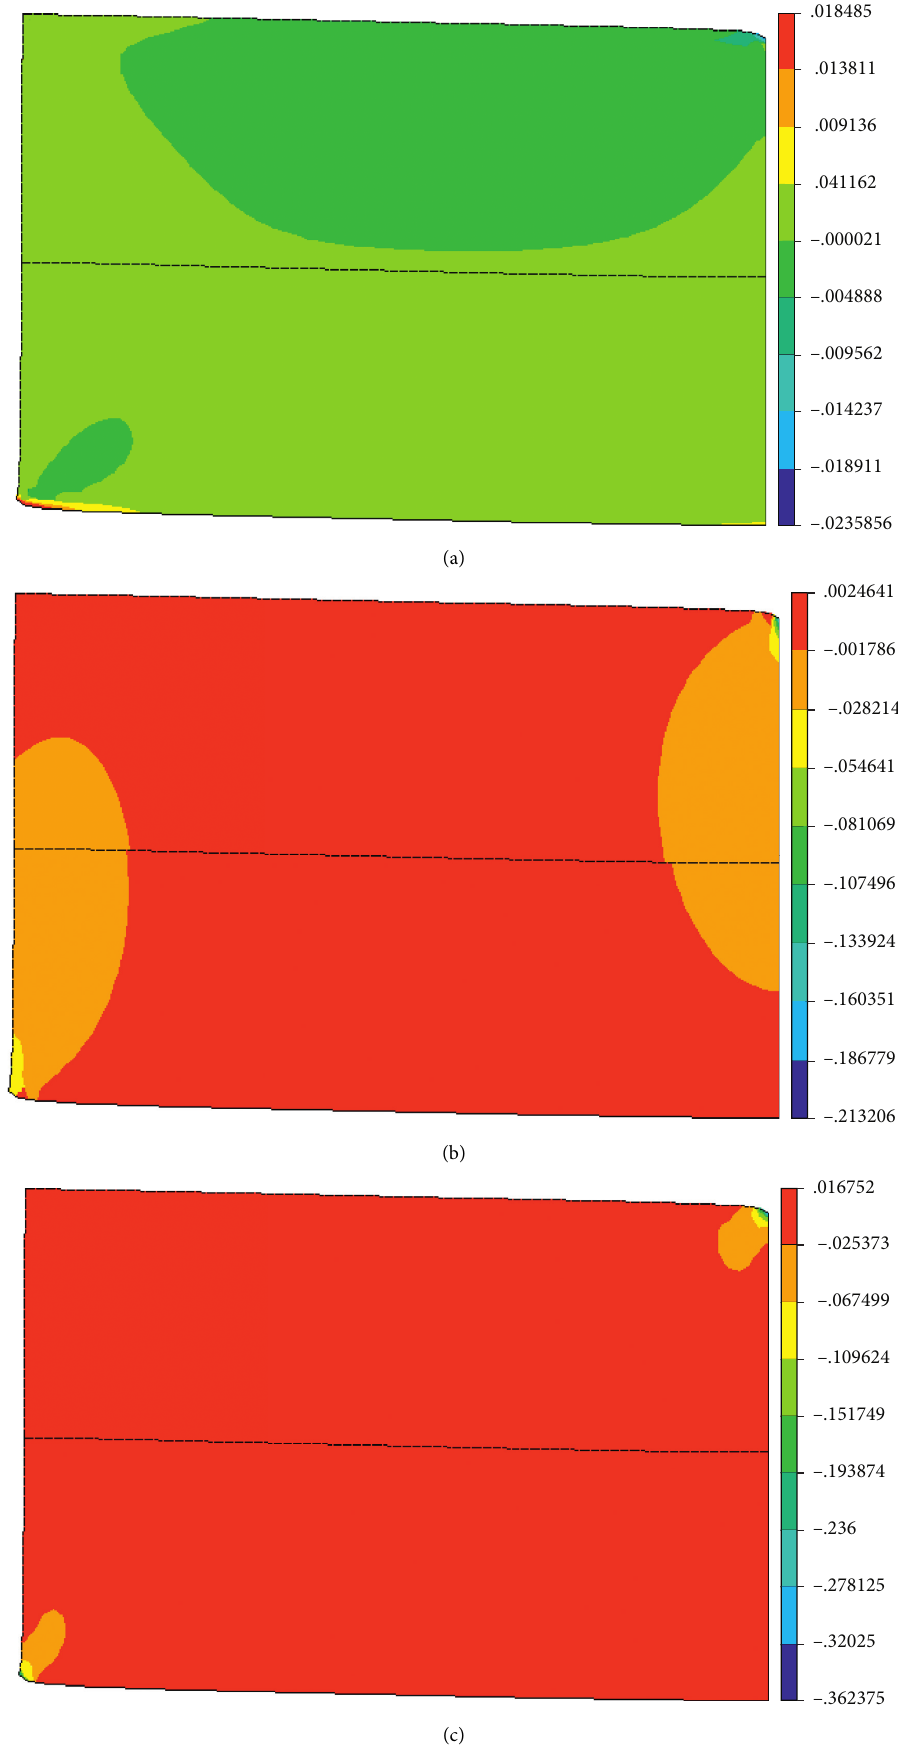
Figure 3: Strain distributions of heterogeneous orthotropic bimaterials: (a) ε